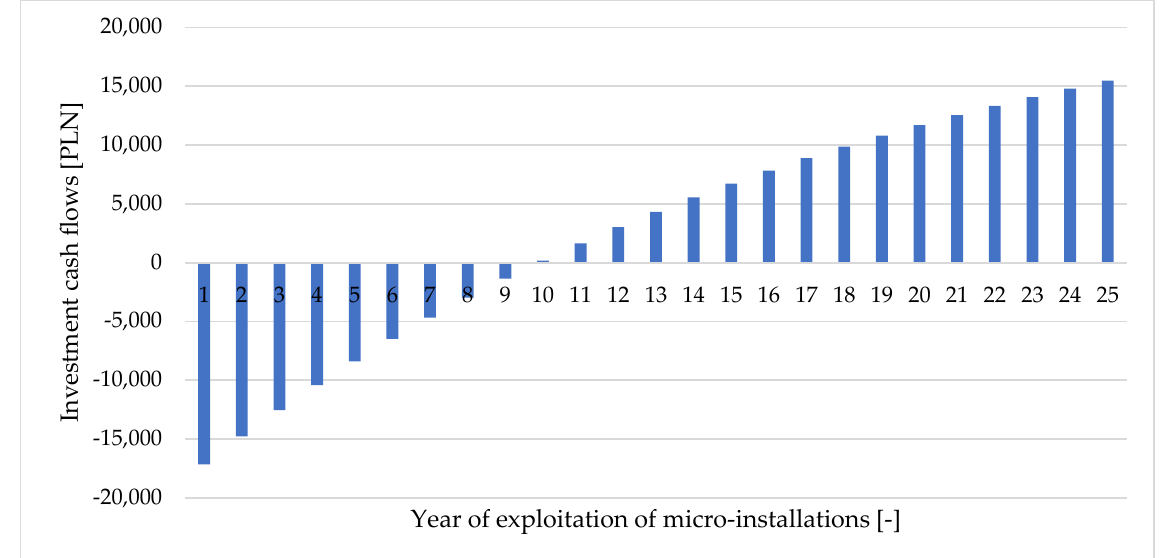
Figure 13. Graph showing the payback period for the capital expenditures incurred in relation to the net-metering system and the 60% self-consumption level.